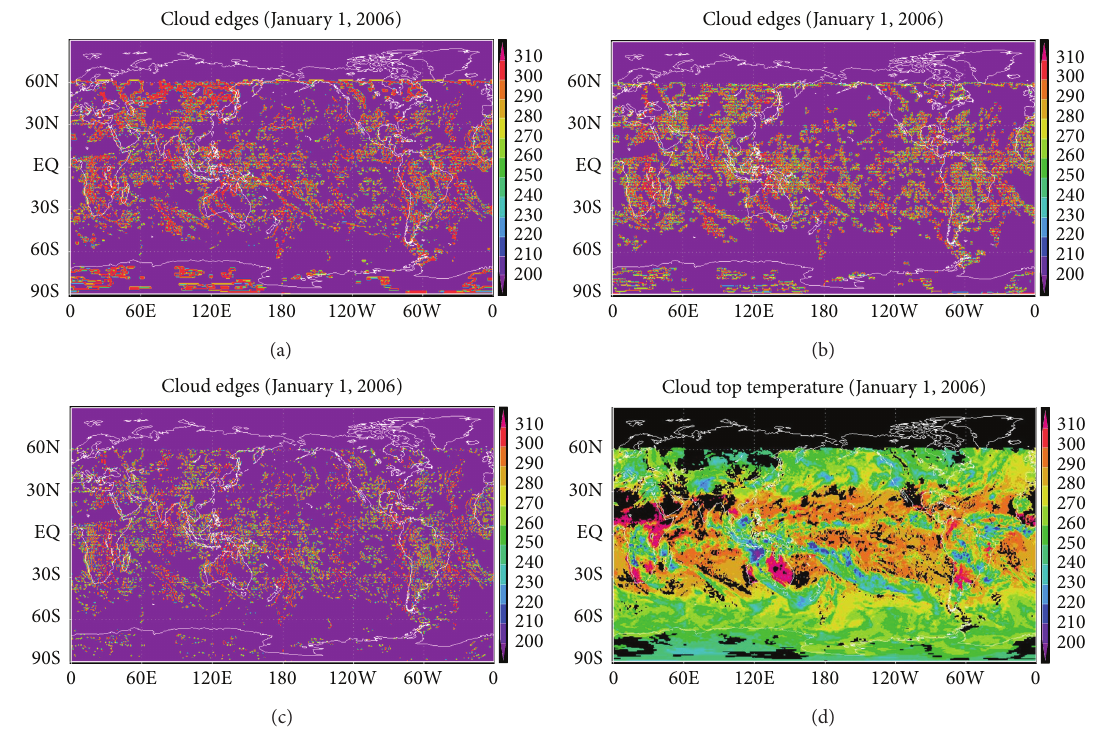
Figure 2: Detection of edges and corners by the Harris (a), SENW (b), and the Sobel (c) edge detectors; the colored CTT image (d) for visual comparison with the edge detectors. On the edge detectors images, the purple background represents nonmaxima or nonedges and the remaining colors represent maxima or edges and